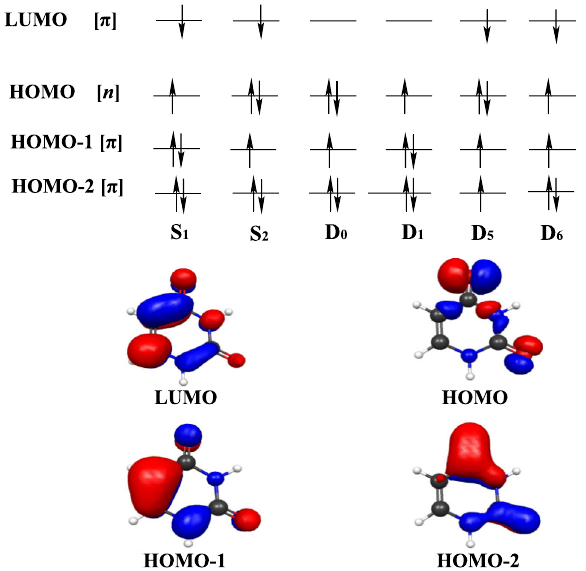
FIG. 4. Dominant electronic configuration and characters for relevant states of the neutral molecule and the ion. The partic- ipating orbitals are shown as well. The orbitals are shown for the molecule in the same orientation as shown in Fig.